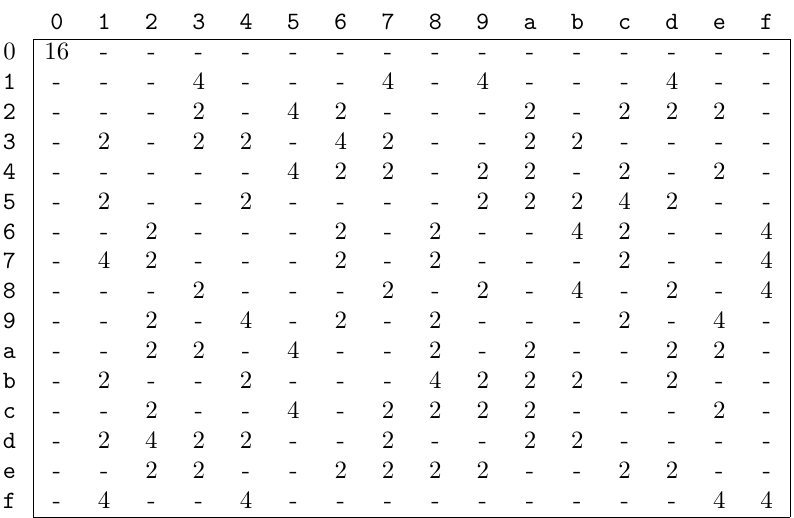
Table 2: DDT of PRESENT ’s 4-bit